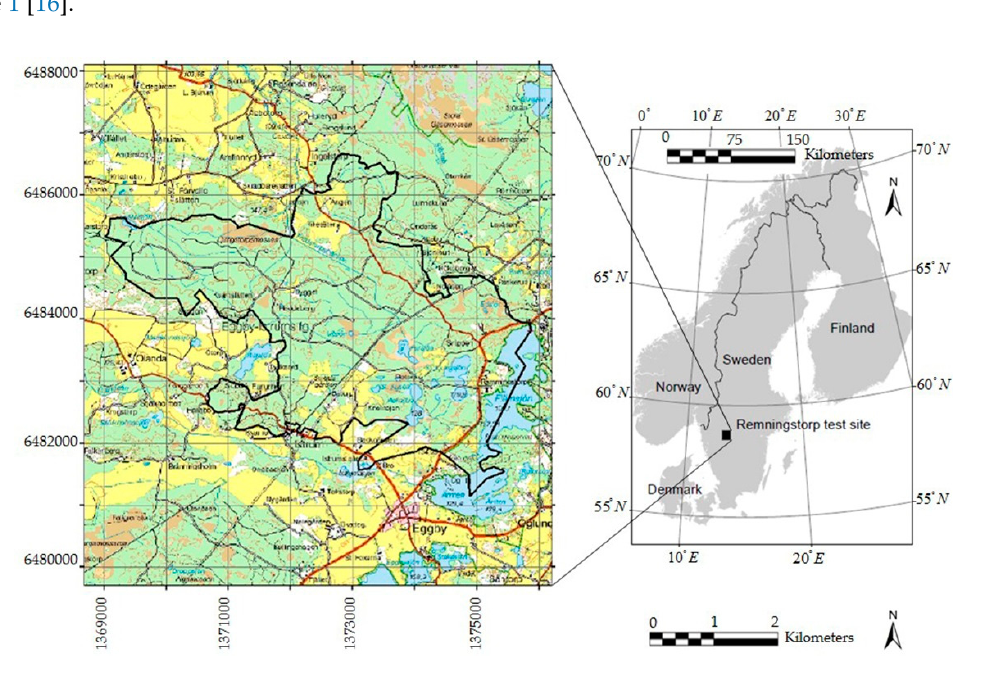
Figure 1. The location of the Remningstorp test site in Sweden [16].